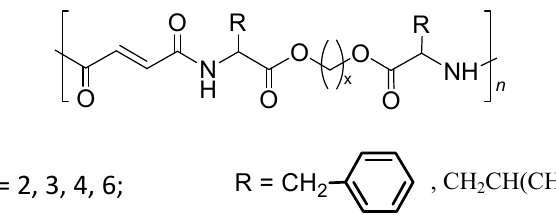
Figure 31. Unsaturated AABBP composed of fumaric acid.